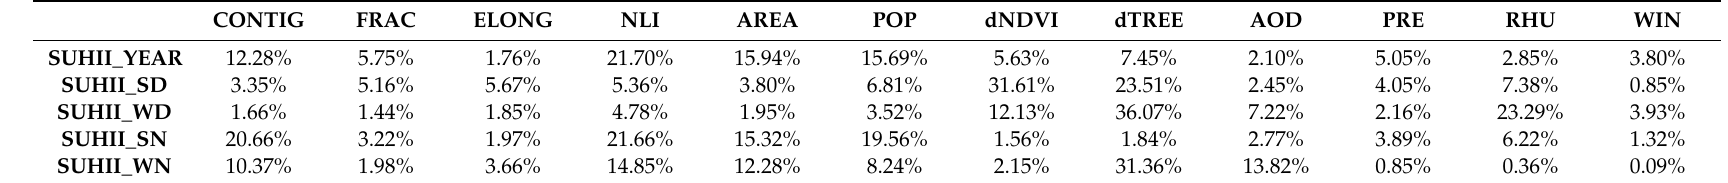
Table A3. Relative contribution